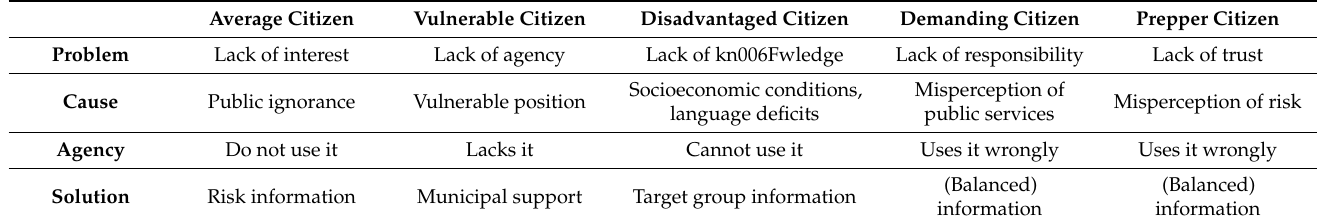
Table 1. Municipality officials’ different views on